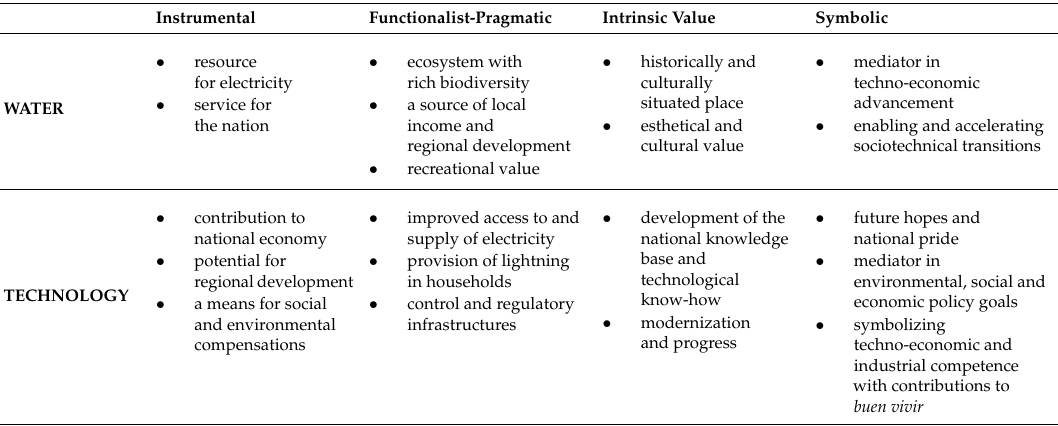
Table 1. Expectations towards water and technology in the context of the Coca Codo